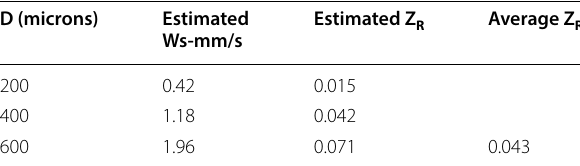
Table 2 Estimated values of Ws by Eq. 5 and corresponding values of Z for the Usumacinta river R